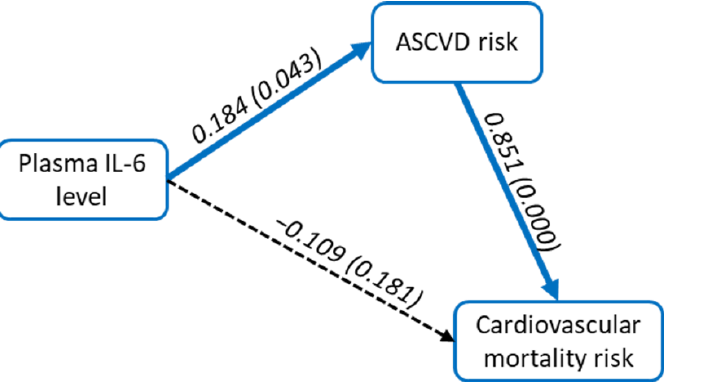
Figure 2. XY correlation plot between plasma IL-6 and ASCVD and CV mortality risk scores: ( a ) XY correlation plot between plasma IL-6 and ASCVD risk score; ( b ) XY correlation plot between plasma IL-6 and CV mortality risk score. Plasma IL-6 levels were measured at pg/mL unit.